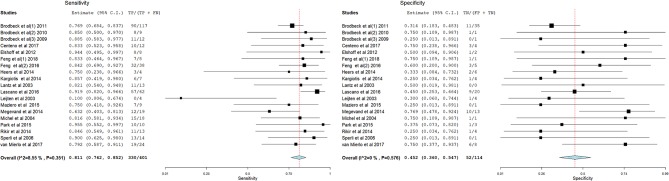
Forest plot showing sensitivity and specificity of the II-ESI studies (individual studies: size of the squares are proportional to weights used in meta-analysis; the summary measure: center line of the diamond; associated 95% confidence intervals: lateral tips of the squares and the diamond).